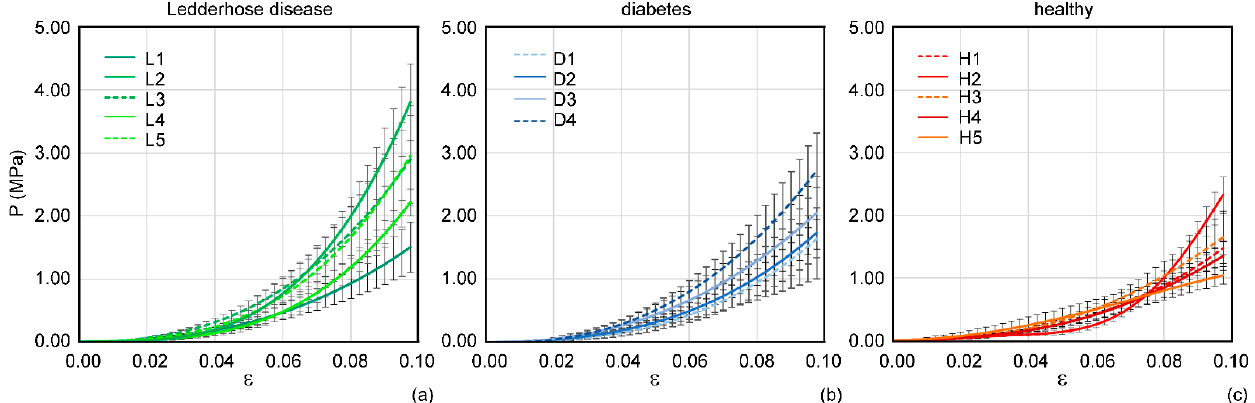
Figure 3. Mechanical response of a PF sample, in terms of nominal stress P vs. nominal strain ε , during five loading–unloading cycles at 10% strain.